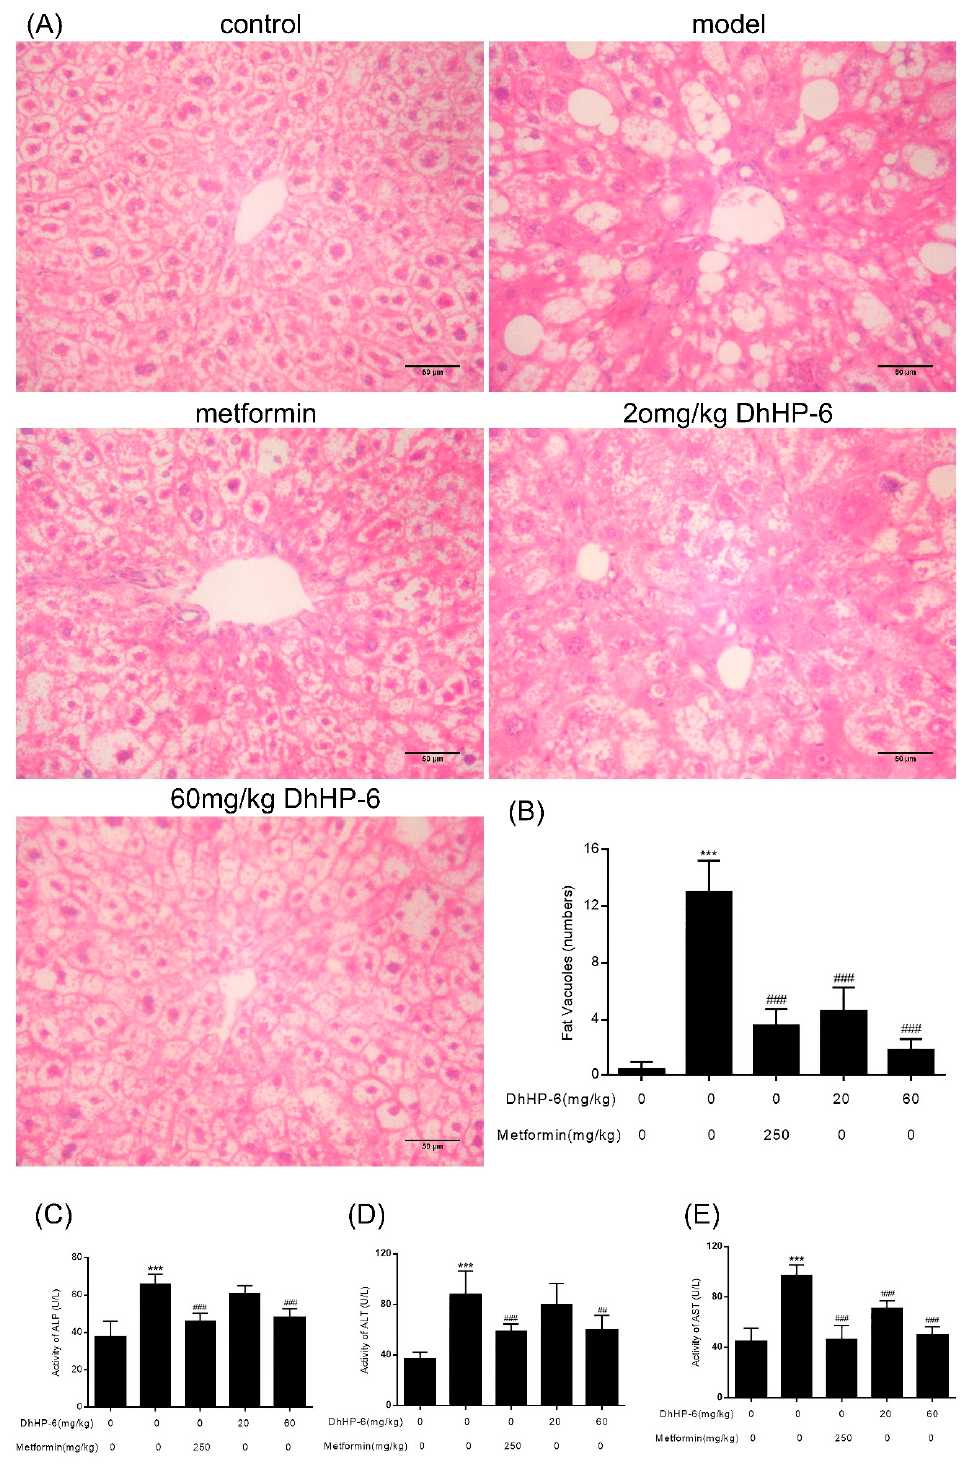
Figure 9. Effects of DhHP-6 on the structure and function of T2DM mice liver. ( A ) H&E was performed to evaluate the effect of DhHP-6 on the histology of T2DM mice liver. ( B ) Histopathological liver damage scores in each group were calculated based on the number of fat vacuoles. ( C–E ) Alkaline phosphatase (ALP), aspartate transaminase (ALT), and alanine transaminase (AST) as liver function markers in serum were measured. All results presented are means ± SD, n = 8. *** p < 0.001 vs. control group. ## p < 0.01, ### p < 0.001 vs. model